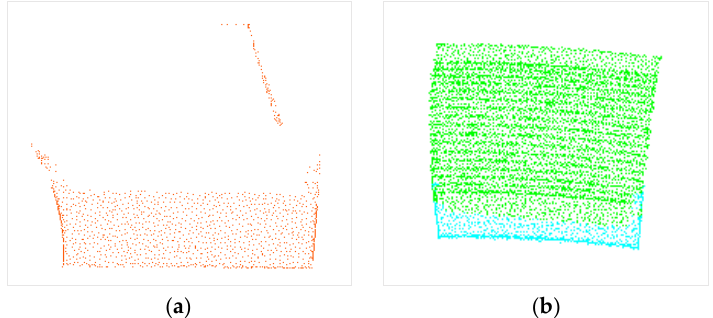
Figure 15. Patches extracted from the free surface are disconnected in the fandisk model: ( a ) two unconnected plane point sets; ( b ) patch overlap between the plane and cylindrical surface.